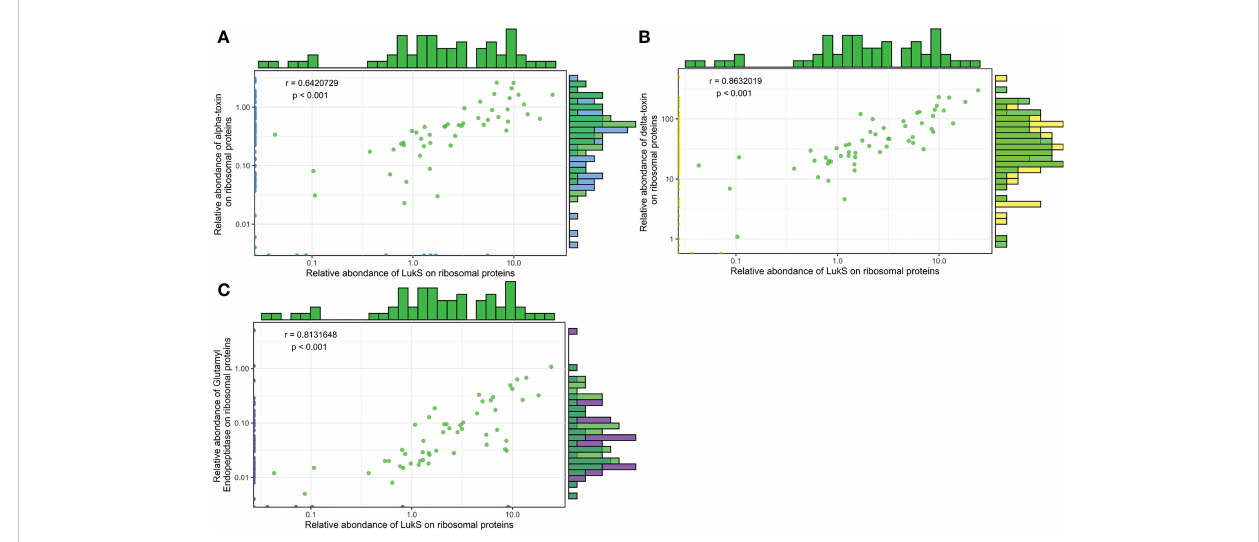
FIGURE 9 The expression levels of Hla, Hld, and SspA are correlated with PVL expression. Log2-transformed Hla (A) , Hld (B) , and SspA (C) relative quantities were plotted against the log2-transformed relative quantities of LukS. The density of strains expressing similar protein quantities is represented by histograms, on top for LukS and on the right side for the protein analysed (Hla, Hld, and SspA), except for null values. Green dots represent strains for which the two proteins of interest were quanti fi ed, and blue, yellow, and purple dots represent strains for which 1 of the 2 proteins of interest had a null value. A Pearson correlation test was